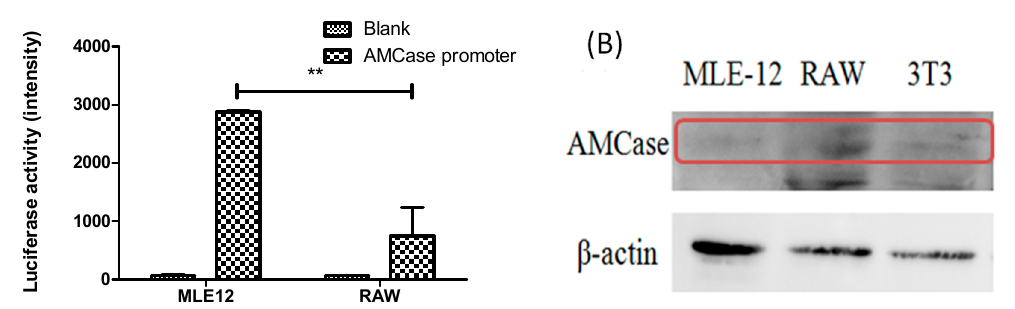
Figure 2. The expression of AMCase. ( A ) Reporter vector containing the AMCase promoter and encoding luciferase was transfected to MLE (mouse lung epithelial)-12 and RAW macrophage cells, and luciferase activity was measured after 48 h of transfection (** p < 0.01, MLE (+AMCase promoter) vs. RAW (+AMCase promoter), unpaired t -test); ( B ) The protein levels of AMCase (shown in the red rectangle) in MLE-12, RAW264.7, and BALB/c 3T3 fibroblast cells were analyzed using Western blotting.